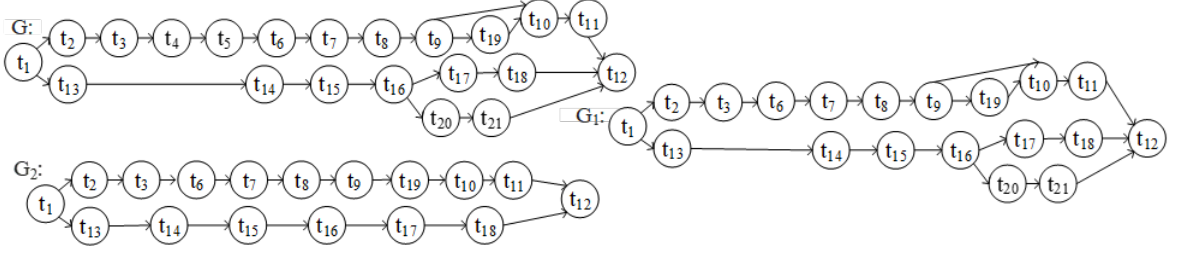
Figure 11. G: The directed graph corresponding to the predefined model, G 1 : The directed graph corresponding to the extracted process model, G 2 : The directed graph corresponding to the process model with noise.